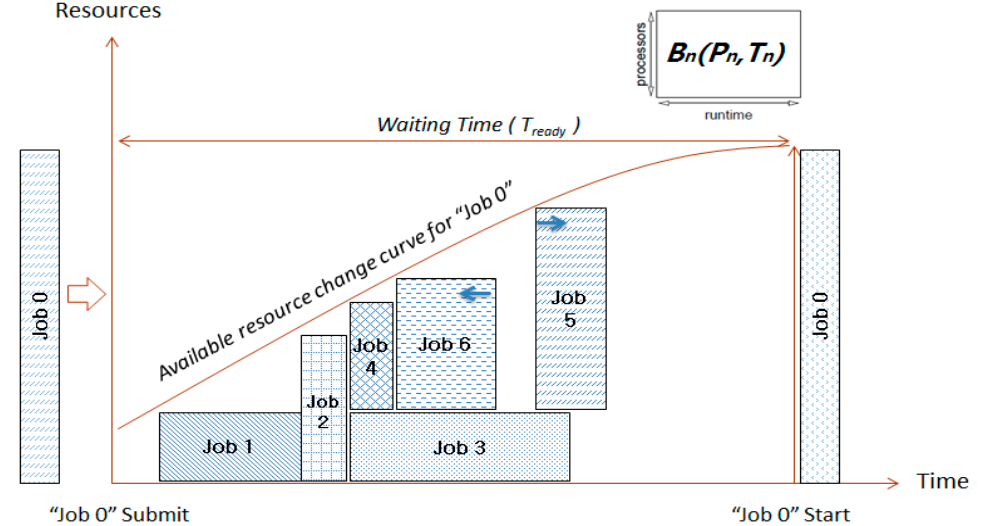
Figure 6. Applying backfilling to available resources before the large-scale job.